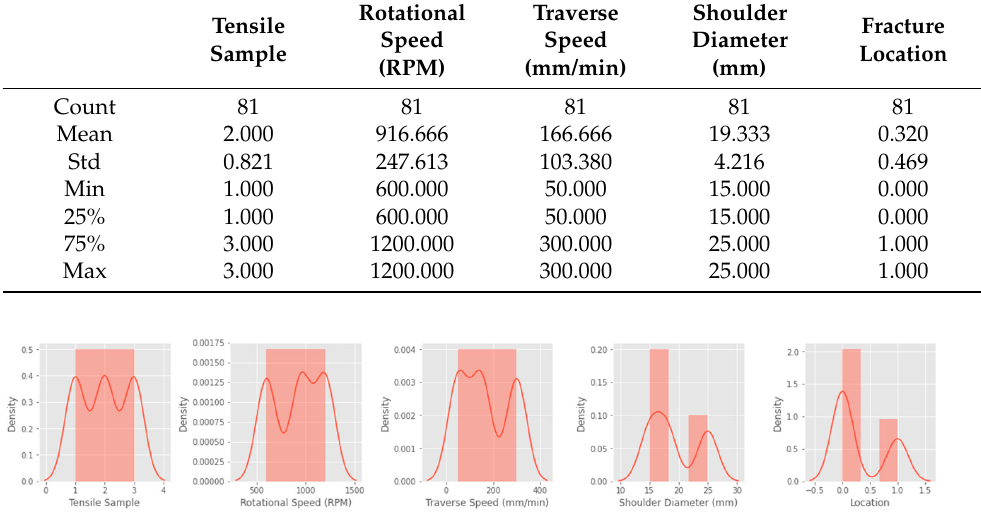
Figure 3. Exploratory data analysis plot.